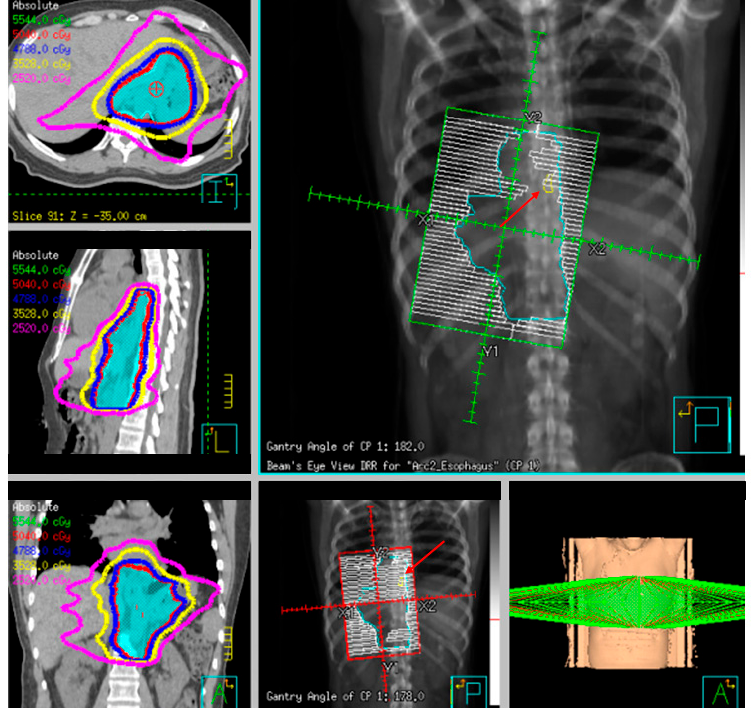
Figure 8. Example radiotherapy plan for image-guided treatment with fiducial contoured (red arrow) and within the planning target volume (PTV).